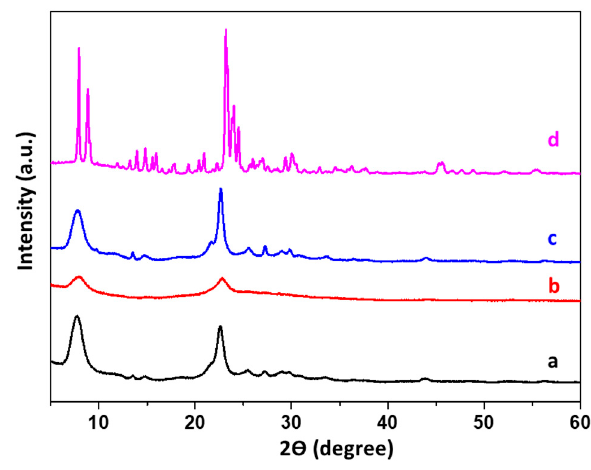
Figure 1. XRD patterns of: ( a ) the bare Beta, ( b ) the 0.4 wt% Sn-Beta, ( c ) the commercial Beta (Beta-COM), and ( d ) the conventional ZSM-5 (ZSM-5-CON).